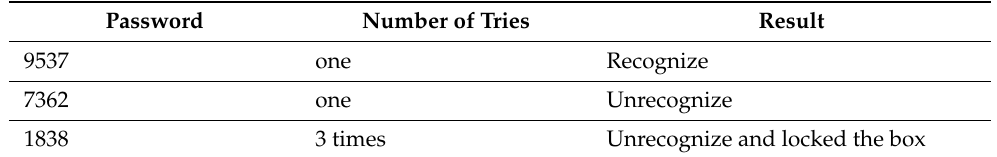
Table 2. Keypad test results with correct and incorrect